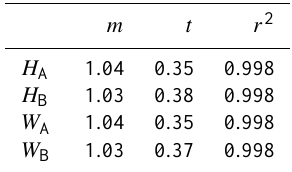
Figure 7. Fourteen Styrofoam particles with maximum dimensions from 2 to 15mm simulate solid hydrometeors to validate the match- ing algorithm